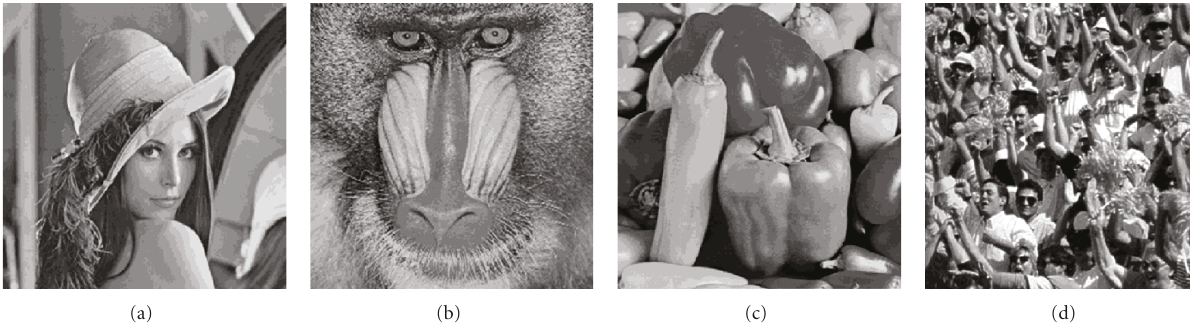
Figure 10: (a) Original Lena image, (b) Original Baboon image, (c) Original Peppers image and (d) Original Crowd image.